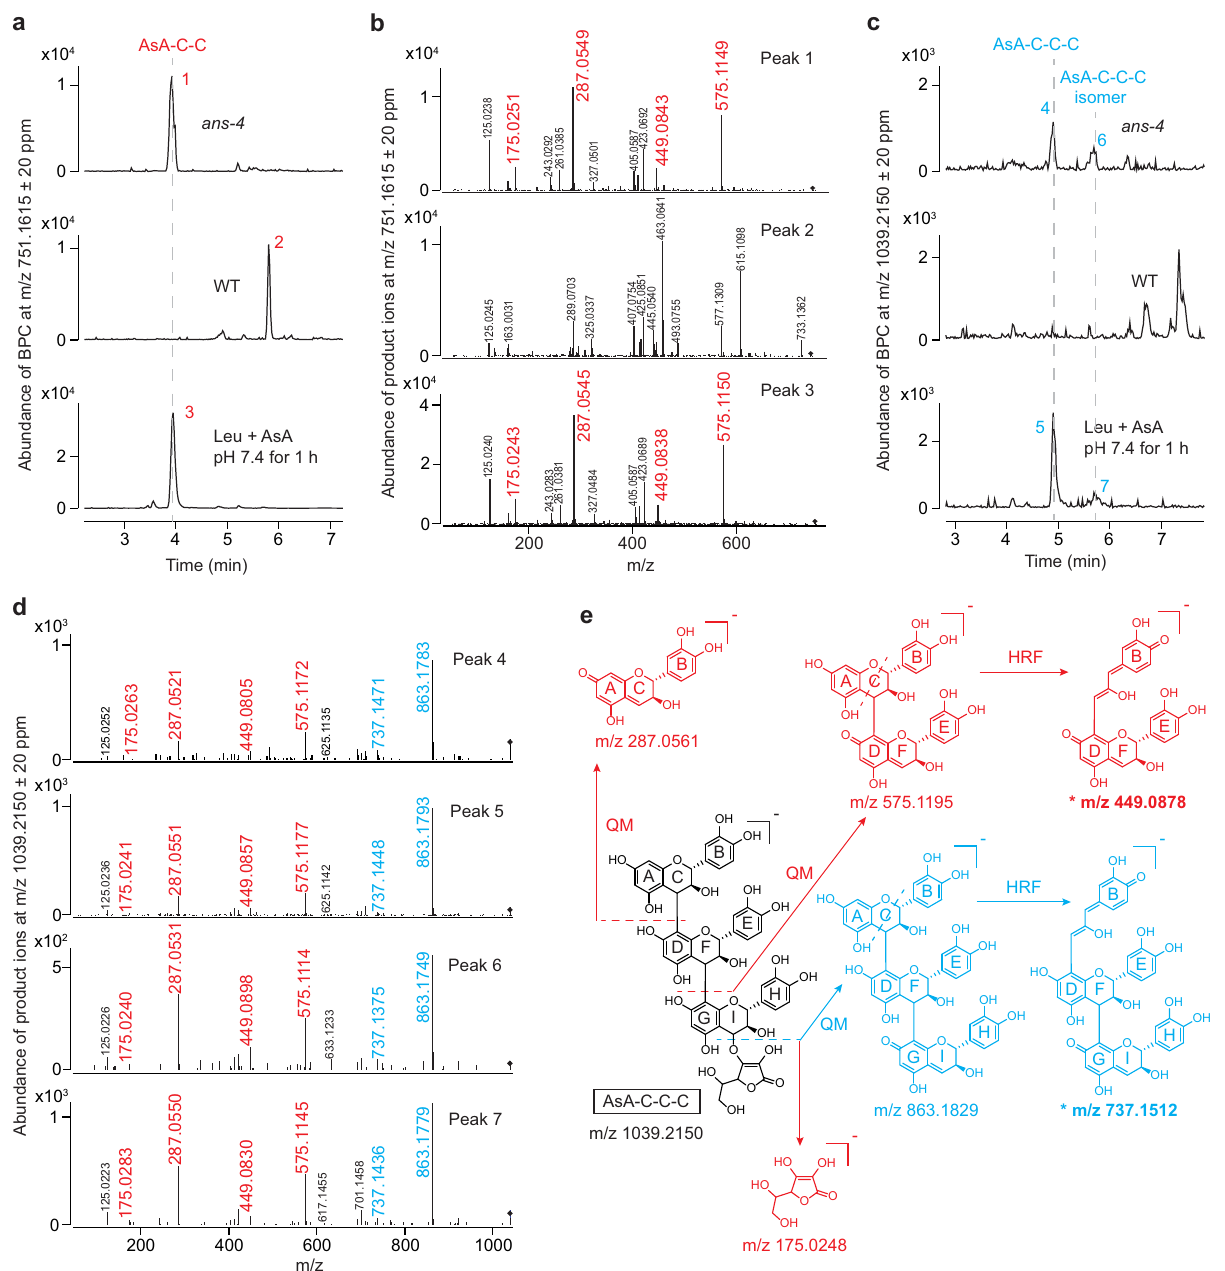
Fig. 5 AsA-C-C and AsA-C-C-C accumulate in 7 DAP siliques of the A. thaliana ans-4 mutant. The soluble PA fraction of 7 DAP siliques of the A. thaliana ans-4 mutant was analyzed in parallel with the product of reaction of AsA + leucocyanidin (Leu) as the standard using UHPLC-QToF. a Base peak chromatogram (BPC) showing that a compound with the same m/z (751.1615 ± 20 ppm) as AsA-C-C accumulates in the A. thaliana ans-4 mutant. b Product ions of the compounds marked in ( a ). The fragmentation mode deduction supporting the conclusion that compounds 1 and 3 are AsA-C-C is shown in Supplementary Fig. 4. c BPC showing that the compounds with the same m/z (1039.2150 ± 20 ppm) as AsA-C-C-C accumulate in the A. thaliana ans-4 mutant. d Product ions of compounds marked in ( c ). e The fragmentation mode deduction supporting the conclusion that compounds 4 and 5 in ( c ) are AsA-C-C-C based on the product ion pro fi les. The asterisks indicate the critical fragments supporting the natural IFL. The corresponding scheme supporting the conclusion that compounds 6 and 7 are AsA-C-C-C isomers is shown in Supplementary Fig. 5. The m/z values and the chemical formulae in red are shared by both AsA-C-C and AsA-C-C-C, whereas the m/z values and the formulae in blue are unique to